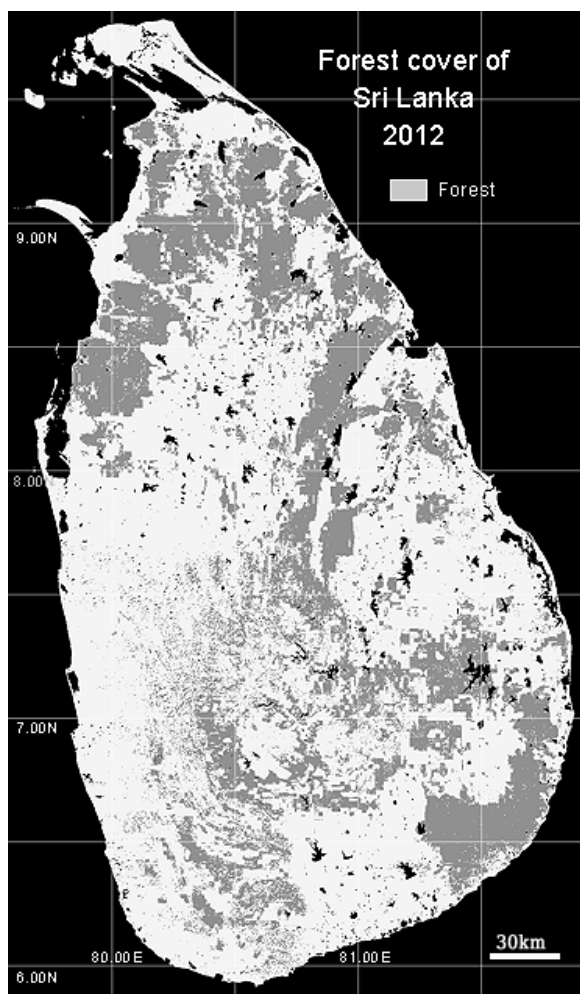
Figure 6. Forest cover of 1988.